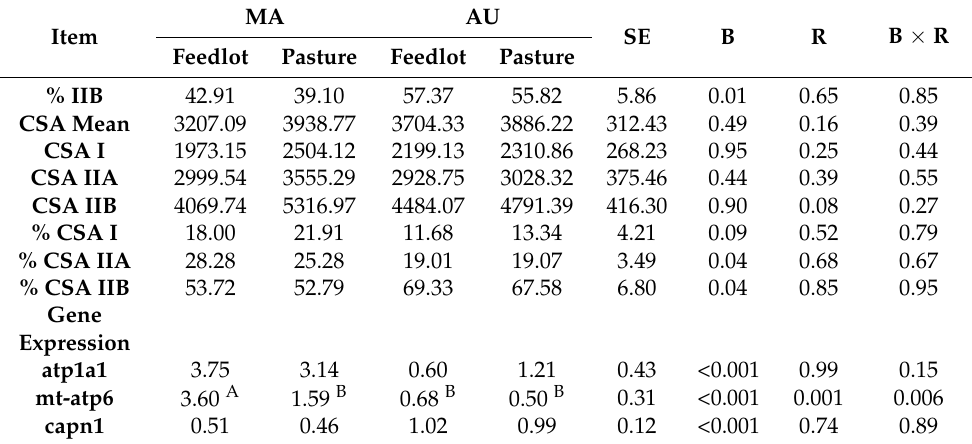
1 Acronyms used in the table: “SE” Standard Error; “mean area” average of muscle fibre cross-sectional area, without considering the fibre types; “CSA” cross-sectional area; “% CSA” calculated percentage of cross-sectional area per fibre type; capitalized apexes “A”, “B” within a row mean significant differences with p <